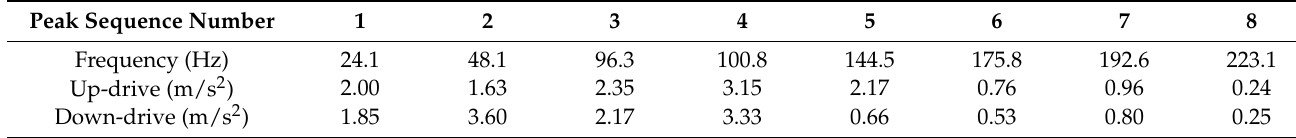
Table 4. Frequency domain peak value of vibration response in different running directions of elevator.